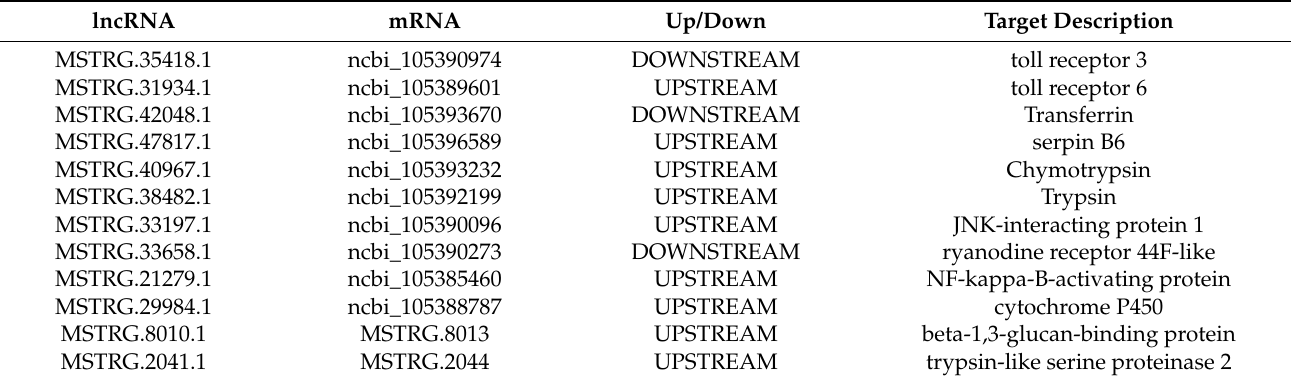
Table 2. Immune-related cis -acting lncRNAs and their target